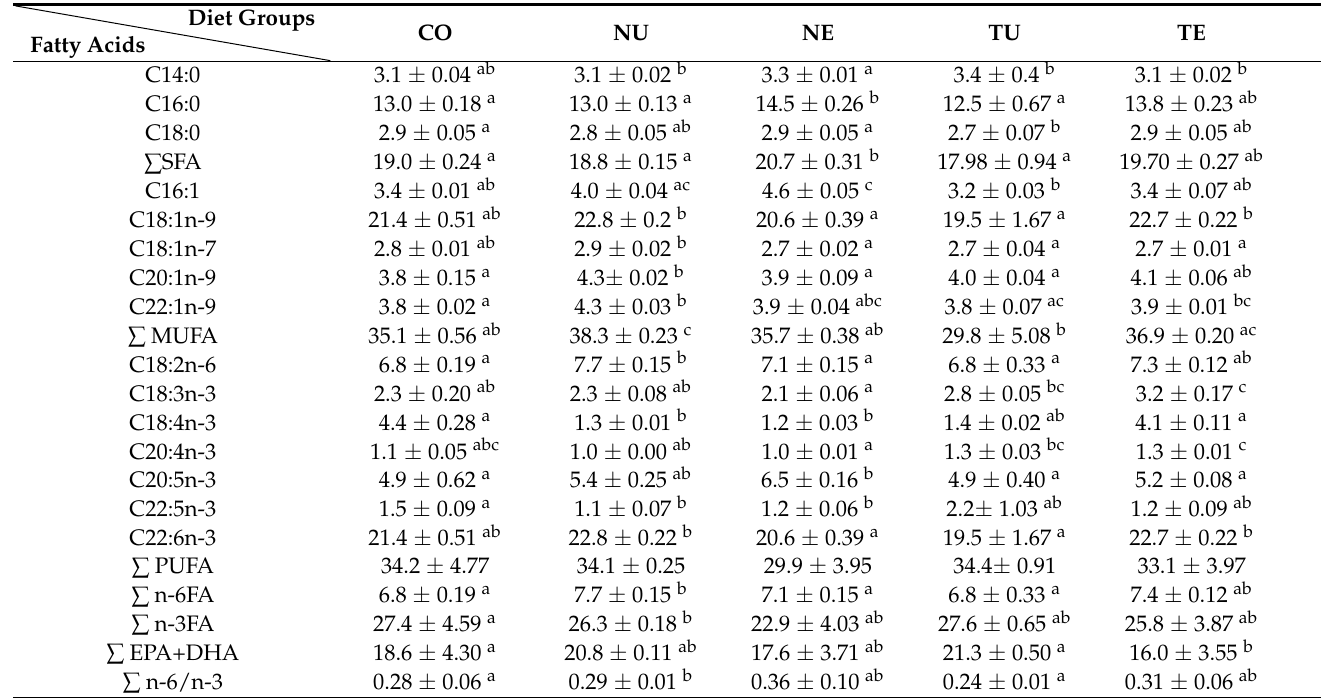
Values are expressed as mean ± sem (n = 4 replicates). Values in the same row with different superscript letters ( a,b,c ) indicate significant differences ( p < 0.05). SFA—Saturated fatty acids; MUFA—monounsaturated fatty acids; PUFA—polyunsaturated fatty acids; n-6—omega-6 polyunsaturated fatty acids; n-3—omega-3 polyunsaturated fatty acids; EPA + DHA—Eicosapentaenoic acid and Docosahexaenoic acid; n-6/n-3—ratio of n-6 PUFA/n-3